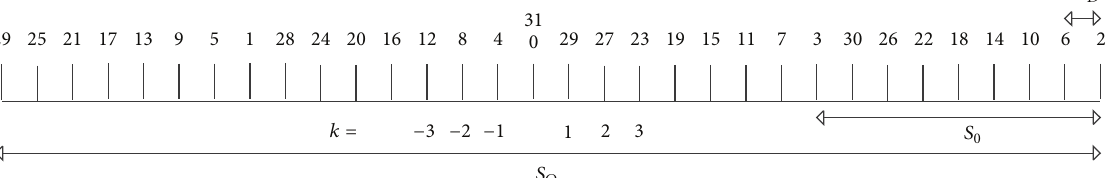
Figure 2: Ground track sequences when the parameter 𝑄 = 14 + 23/31 and subcycles corresponding to different offsets.